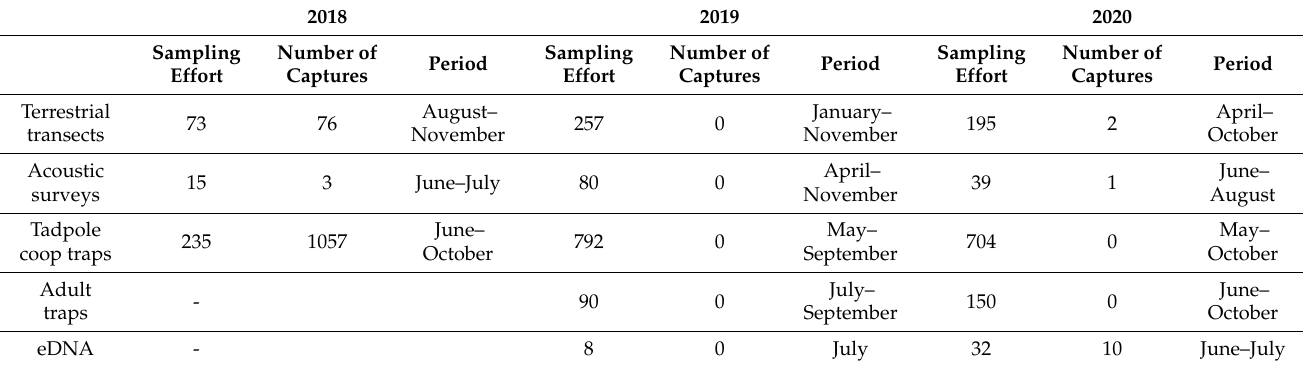
Table 1. Capture effort and results via traditional methods. Sampling effort: for terrestrial transects, it was measured as the total number of travels along transects. For acoustic surveys, it was the number of 15 min stops made to listen to bullfrogs along all of the travels. For tadpole trapping, it was the total number of visits to the coop traps. For adult traps, it was the total number of visits to the traps. Captures are the number of tadpoles or juvenile individuals captured or listened to. All tadpoles and juvenile individuals were captured within the ground zero except for one deceased individual